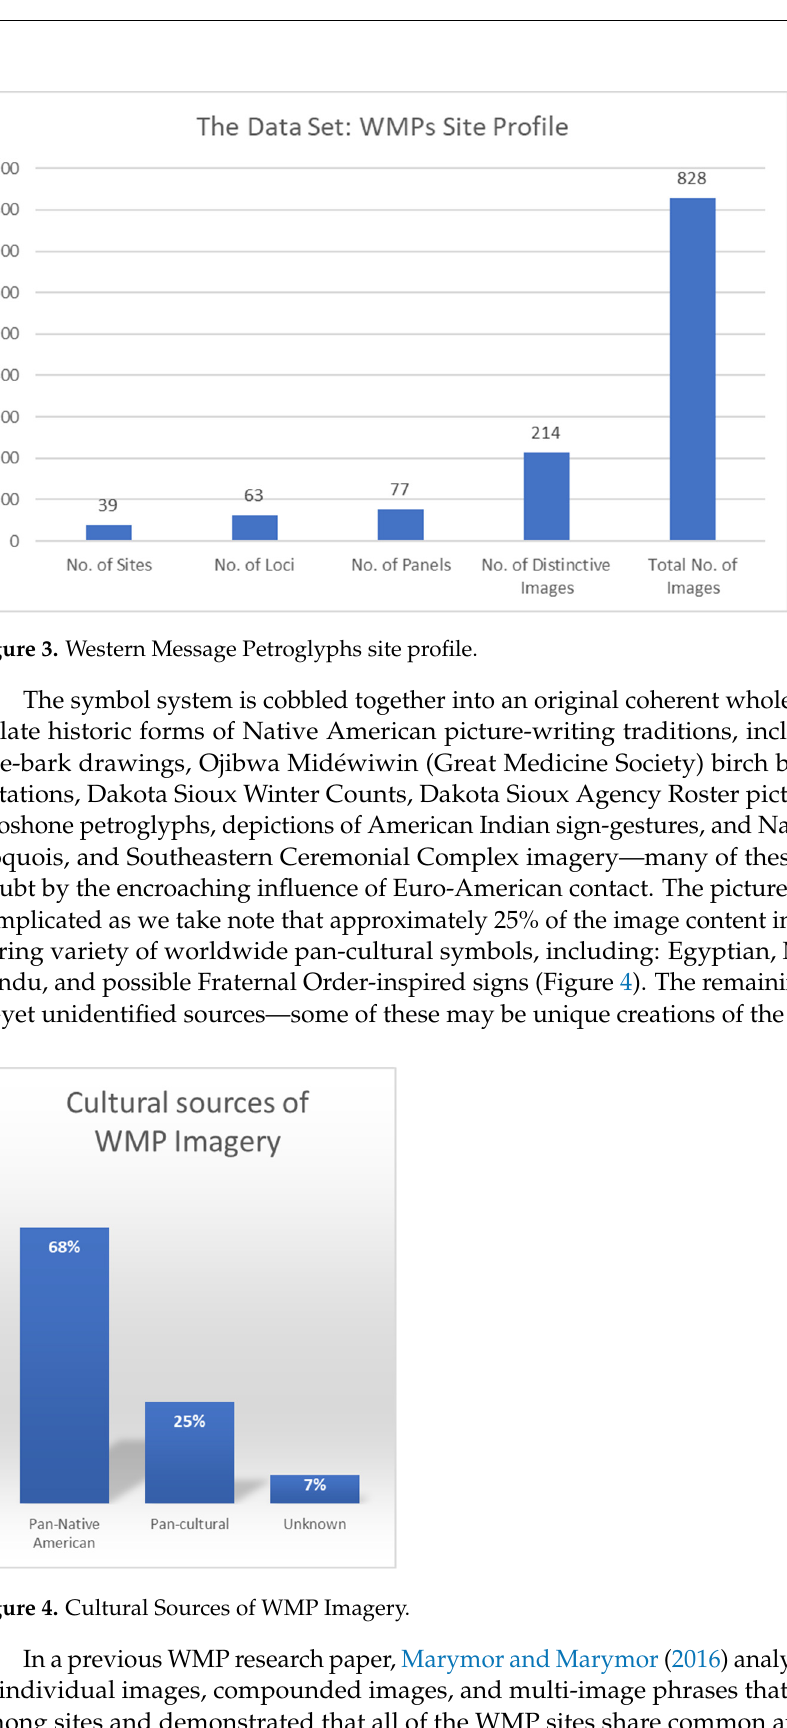
Figure 4. Cultural Sources of WMP Imagery.